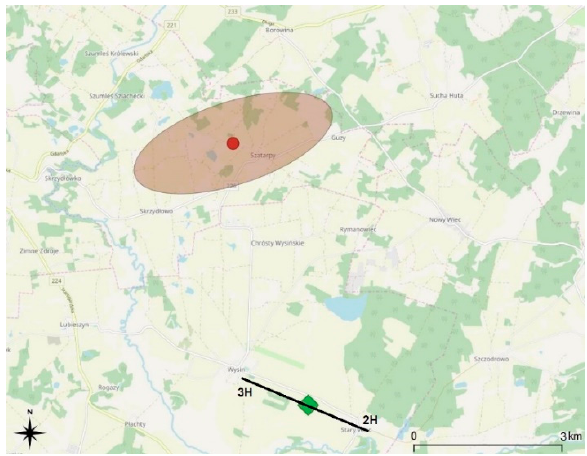
Figure 4. Location of the epicenter (red circle), errors ellipse, Wysin site (green diamond), and approximate extension of the horizontal